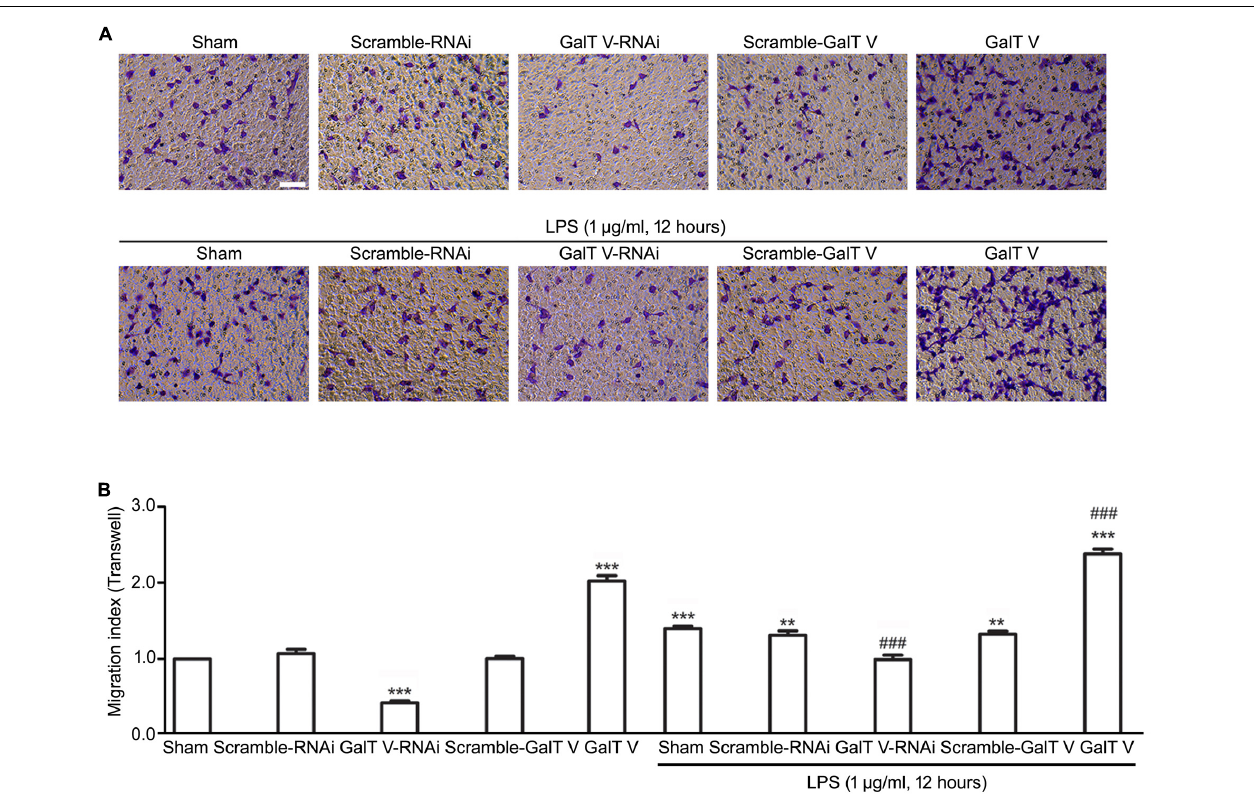
FIGURE 2 | Promotion of β -1, 4-GalT V on cell migration. HAPI cells with designated constructions as indicated were treated with LPS (1 µ g/ml, 12 h). (A) Representative images for migrated cells were labeled by crystal violet (blue); scale bar, 100 µ m. (B) Quantification of migrated cells [migration index (Transwell) = migrated cells/migrated cells in non-treated sham group]. Groups significantly different from non-treated Sham group, LPS-treated Sham group were marked by asterisks, hashtags, respectively. Graphs show mean ± SD; n = 3; ** p < 0.01, *** p < 0.001, ### p <